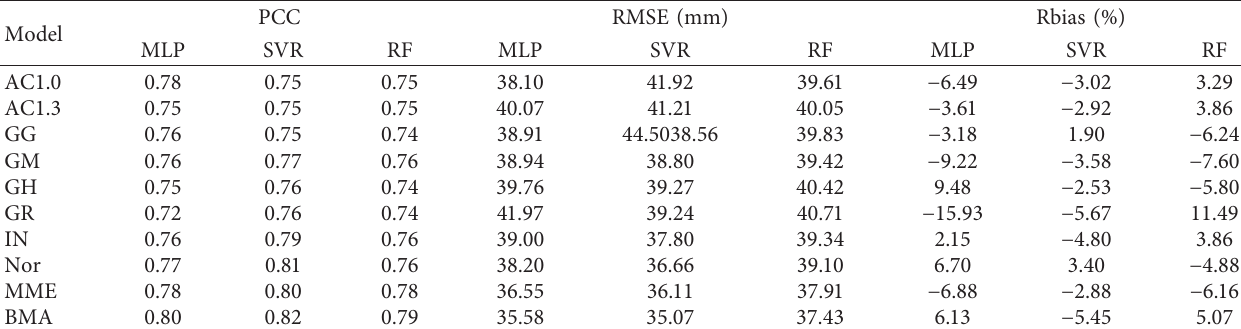
Table 11: The validation results of three methods for this